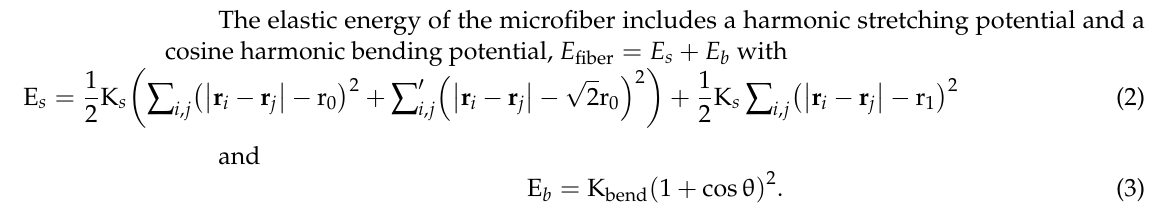
Figure 8. ( a ) Structural composition of plates including tethered base (I), flexible hinge (II), and rigid top (III). ( b – d ) Snapshots of the system after adding 700 dimmers at ( b ) t = 0, ( c ) t = 2 × 10 6 , and ( d ) t = 5 × 10 6 , respectively. ( e , f ) are temporal evolutions of tilting angle and gel height,